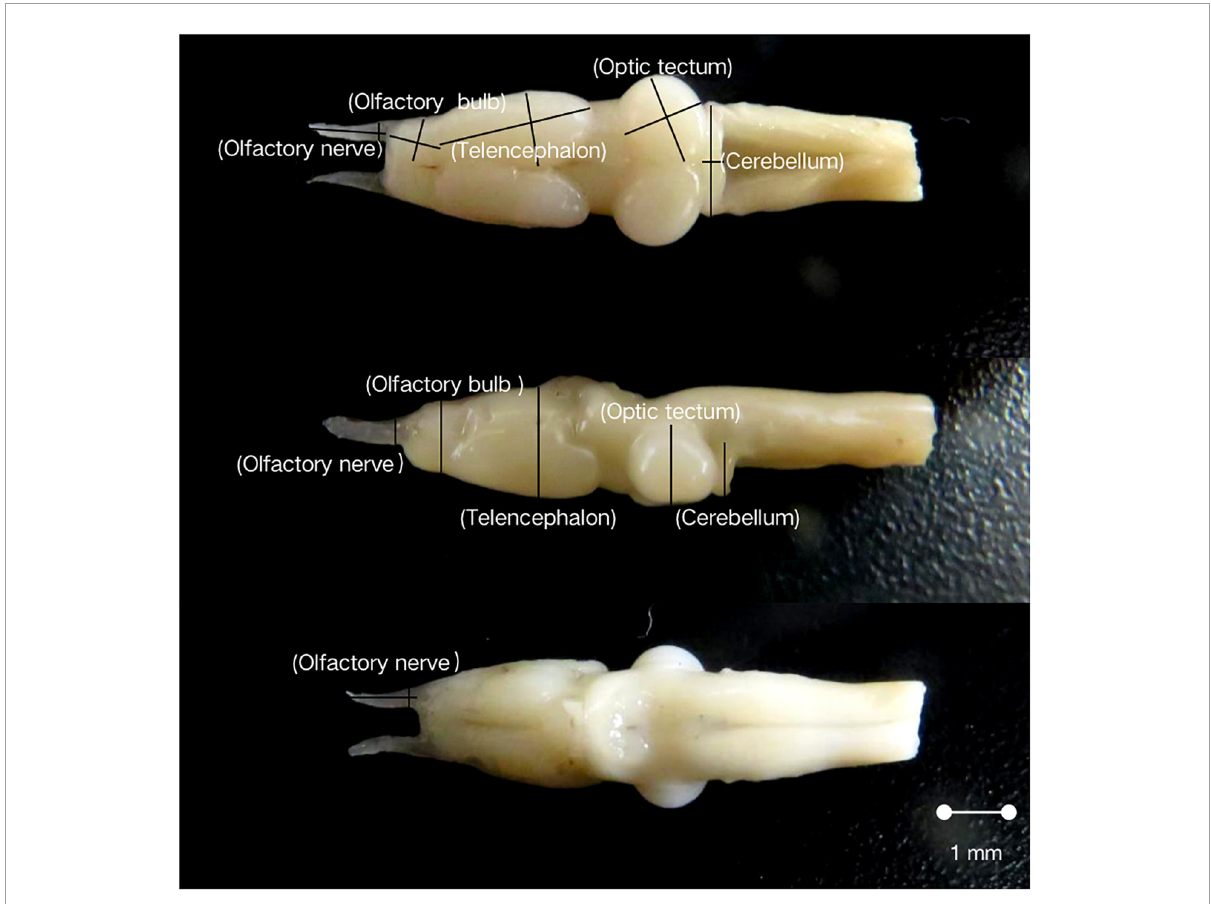
FIGURE2 Dorsal, lateral, and ventral views of the brain in Feirana quadranus . Length, width, and height measures for each of the five brain structures (olfactory nerve, olfactory bulb, telencephalon, optic tectum, and cerebellum) are shown. Further details are found in the “materials and methods”